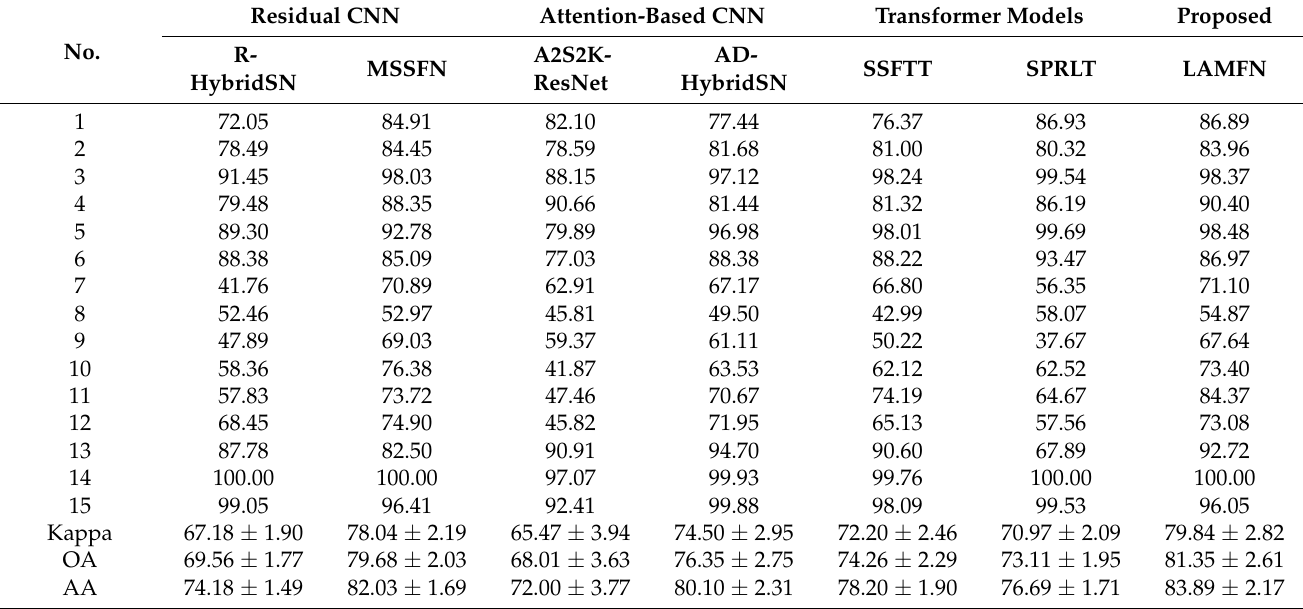
Table 5. Classification results of different models in HU dataset.